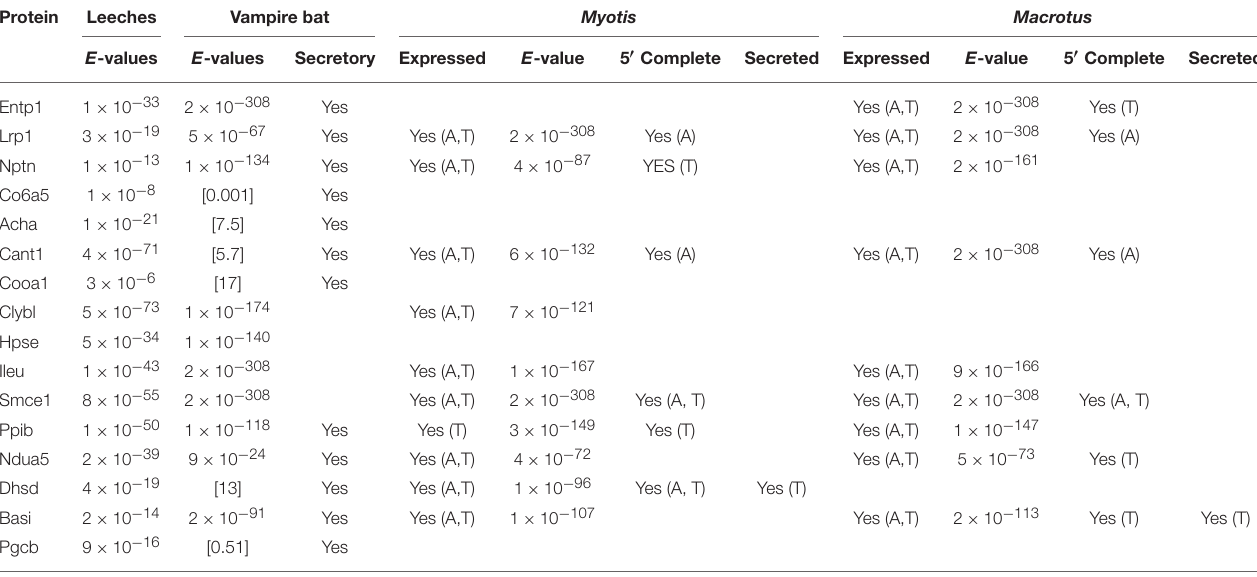
TABLE 2 | Summary information for proteins inferred for both leech and vampire bat salivary gland transcriptomes and frequencies of occurrence in Macrotus and Myotis transcriptomes. Protein Leeches Vampire bat Myotis Macrotus Secretory Expressed E -value 5 ′ Complete Secreted